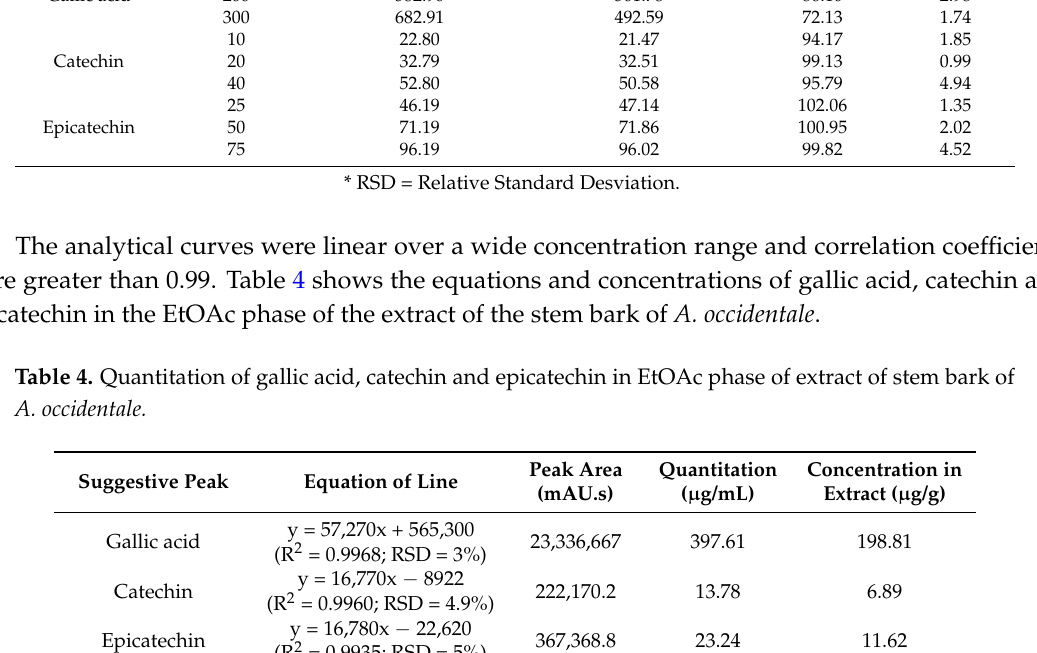
Table 3. Accuracy of HPLC method for gallic acid, catechin and epicatechin at three concentration levels. Concentration Expected Concentration Recovered Compound Level ( µ g/mL) ( µ g/mL) Concentration ( µ g/mL)